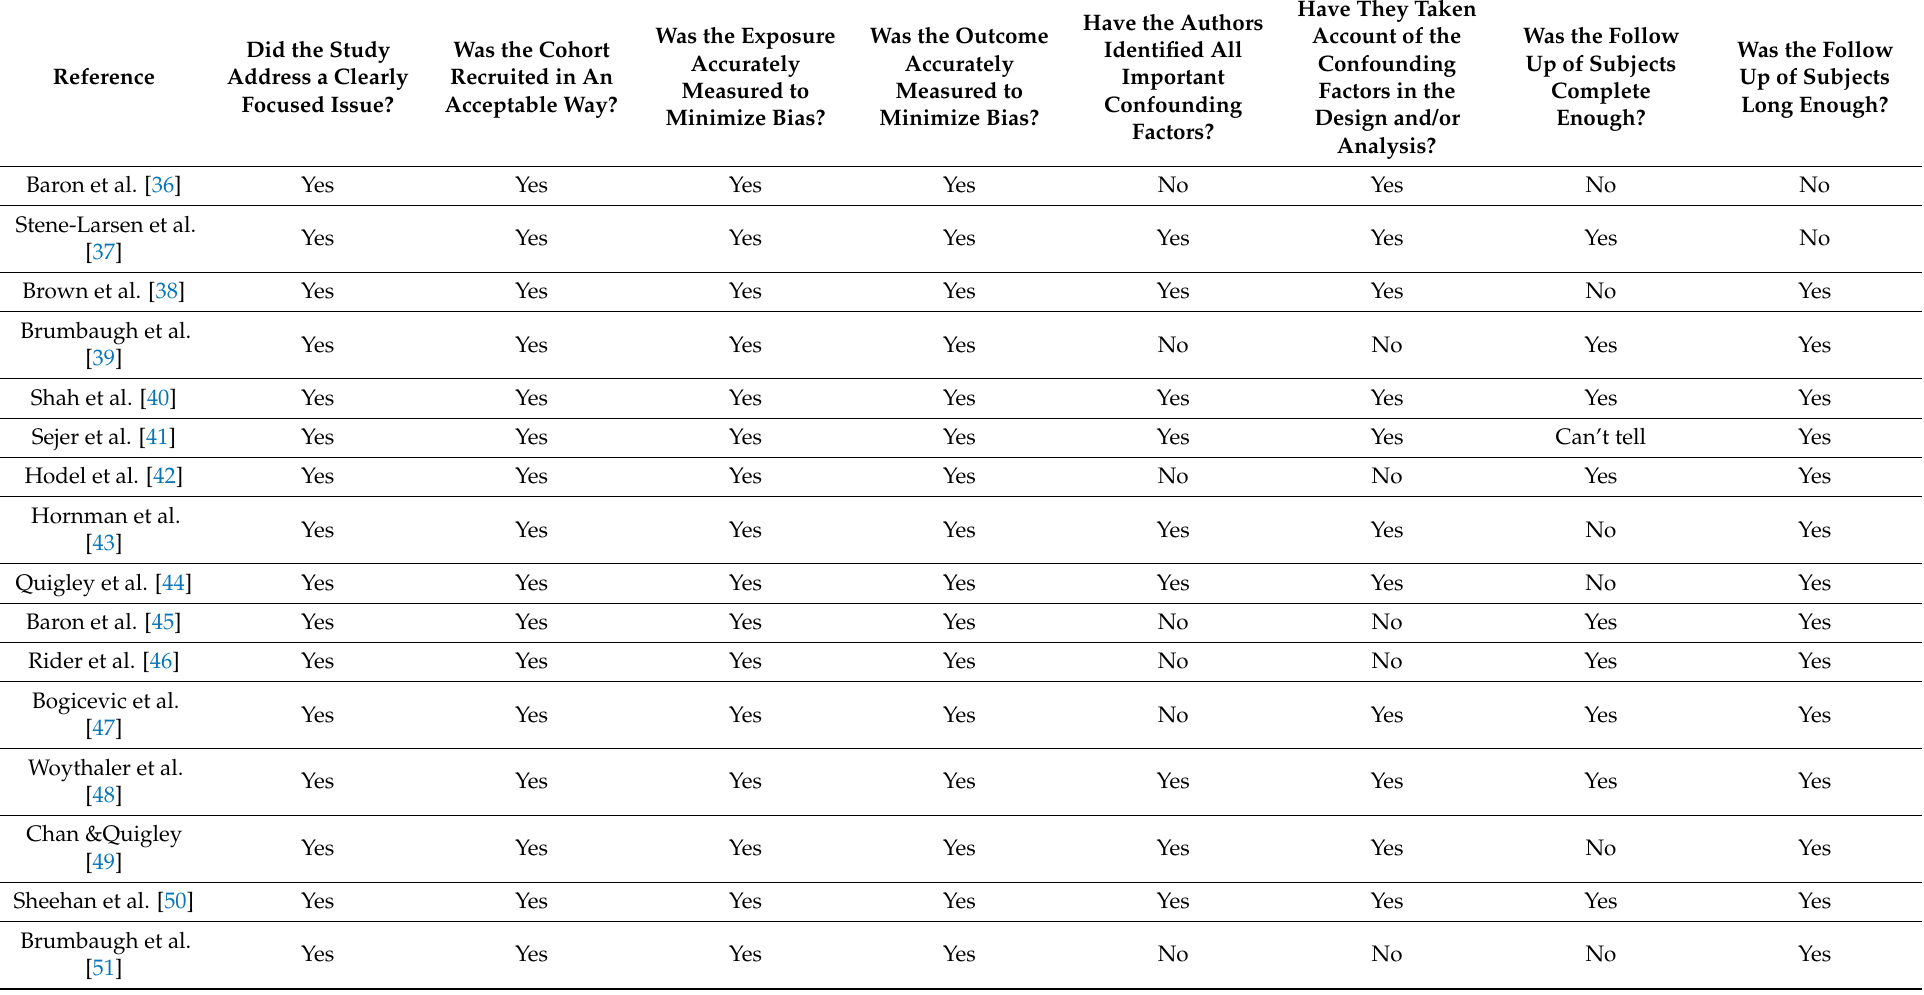
Table 2. Summary of Critical Appraisal Skills Program (CASP)